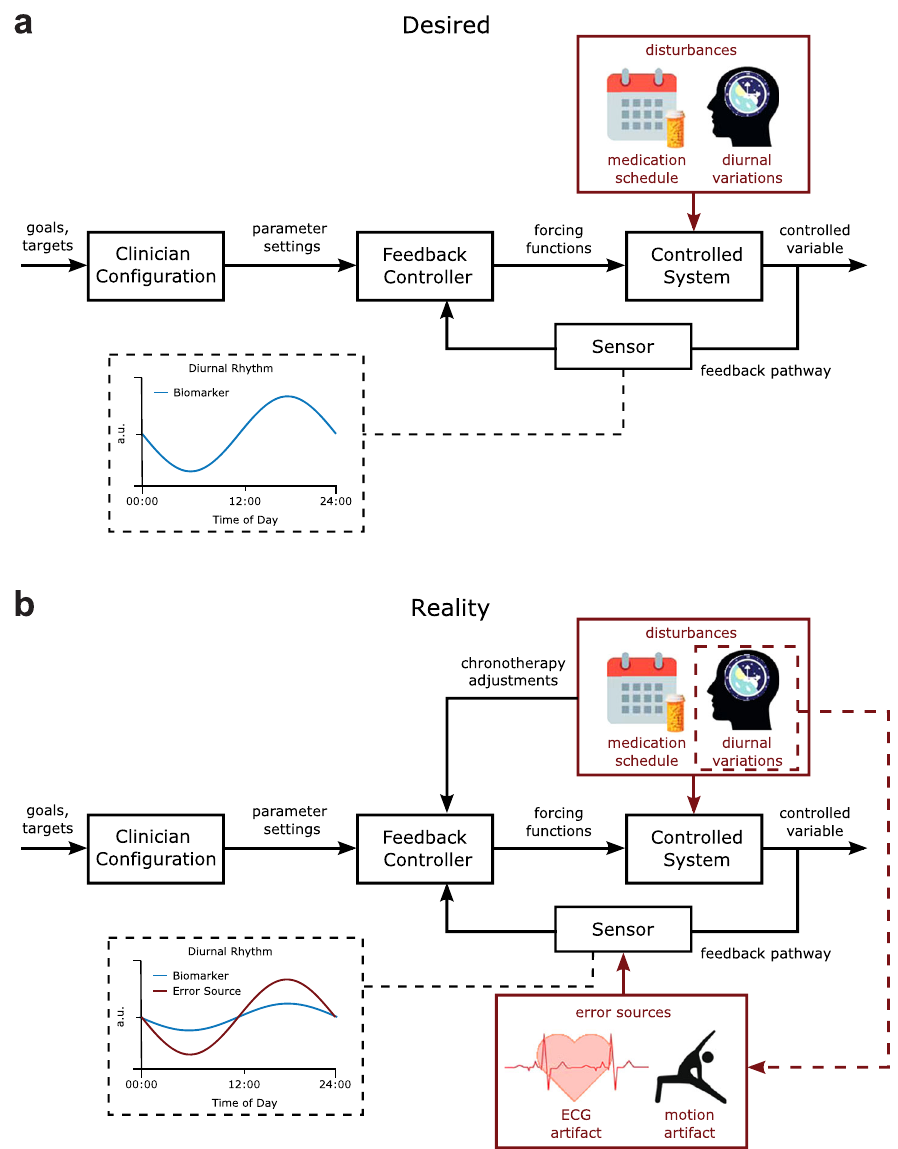
Fig. 6 Desired vs. realistic block diagram of chronoadaptive feedback DBS control system. a Desired control system. In the desired DBS control system, therapeutic goals (i.e., % suppression of beta power) are speci fi ed by clinicians for speci fi c times of the day. A feedback controller modulates the DBS parameters to maintain the controlled variable, the biomarker, at the speci fi ed target level. Time-based adjustments of control goals synchronized to patient-speci fi c chronotypes can then be incorporated to accommodate known disturbances such as the medication-schedule and diurnal variation of the monitored biomarker. In this manner, time-localized adjustments to stimulation parameters are provided in response to physiological variations. b Actual control system. In the actual control system at present diurnal variations in artifact sources may couple into the sensor in the feedback pathway. This can confound observations of physiological fl uctuations in the monitored biomarker signal due to the amplitude of artifacts being greater than the signal of interpolation between their nearest neighbor values. This process was repeated until the data set contained no values with a z -score greater than 6. In the long-term beta monitoring data set, the mean number of outliers per data set was 18 ± 23, and the maximum number of outliers for a time series was 71 (~0.82% of data points over 59 days). For visual comparison between patients and hemispheres, long-term sensing data are sometimes presented as z -scores. For visualization of diurnal patterns in heatmaps and rose plots, and to investigate diurnal correlations between beta and theta power while removing any in fl uence of longer- term drift from the correlation measure, time series are detrended with the Circa Diem toolbox where indicated. De-trending was accomplished by dividing all LFP power measurements for a given day by that day ’ s median value (such that in the detrended data, the median for each day is 1).